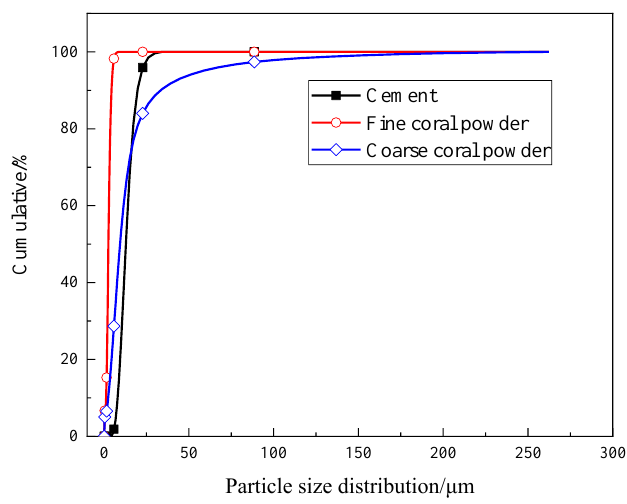
Figure 3. Particle size distributions of the materials used.